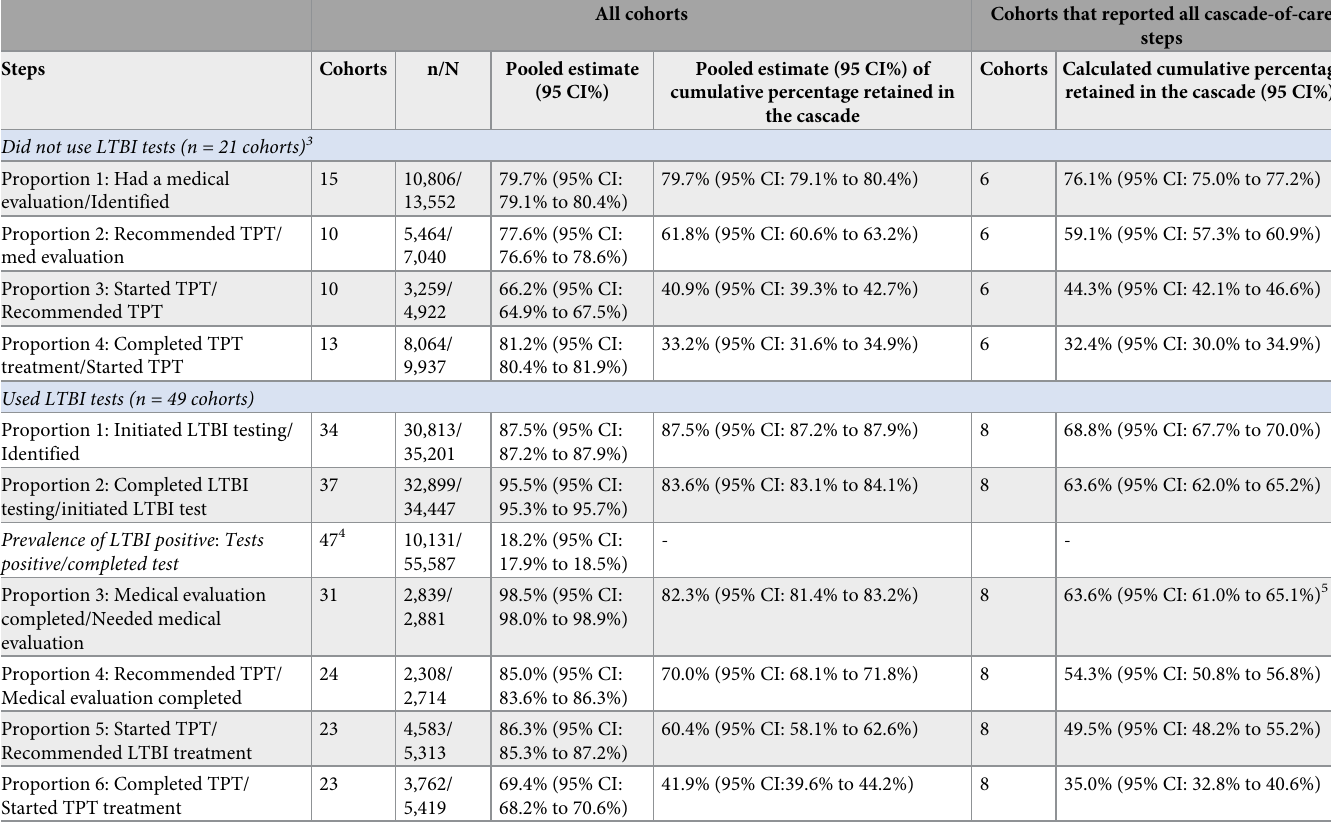
Table 2. Pooled estimate for each step of the cascade-of-care 1 (pooled using fixed effect model). All cohorts Cohorts that reported all cascade-of-care steps Cohorts Pooled estimate Pooled estimate (95 CI%) of Cohorts Calculated cumulative percentage (95 CI%) cumulative percentage retained in retained in the cascade (95 CI%) the cascade